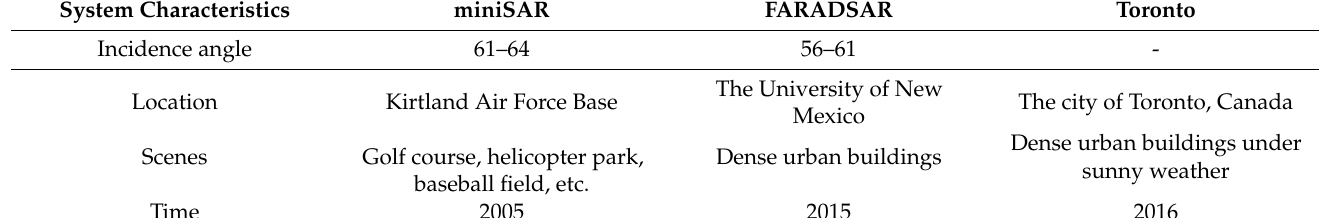
Table 2. The parameters of the miniSAR, FARADSAR, and Toronto datasets.